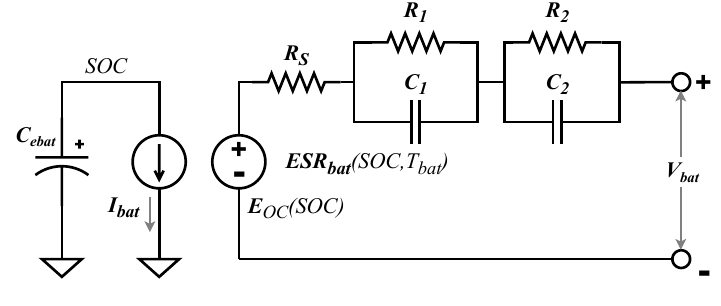
Figure 5. Equivalent circuit model for a Li-ion